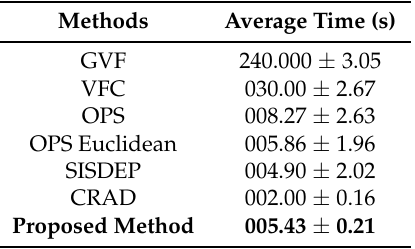
Table 5. Time average and standard deviation of the